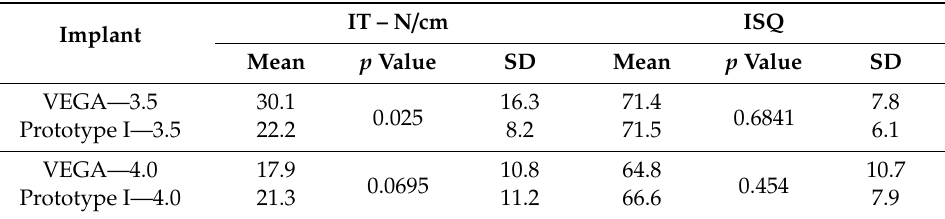
Table 1. Values of the insertion torque (IT) and implant stability quotient (ISQ) from the 1st group, the control, and Prototype I with 3.5 and 4.0 mm diameters; the yellow values are the statistically significant ones.